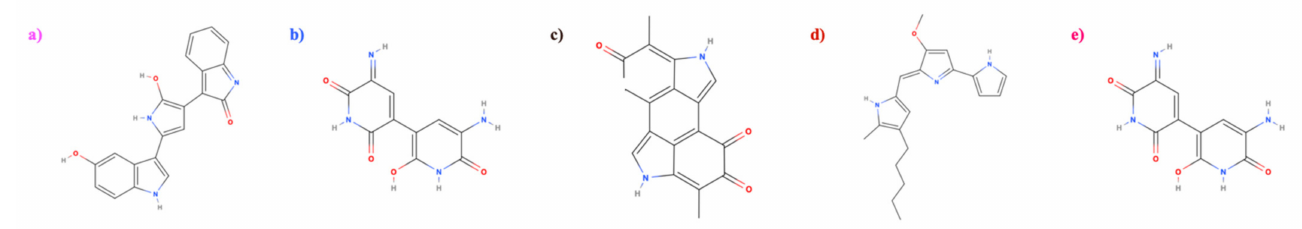
Figure 2. Molecular structures of the following bacterial pigments ( a ) Violacein; ( b ) Indigoidine; ( c ) Melanin; ( d ) Prodigiosin and ( e ) Rhodopsin. (Structures made using MolView software)